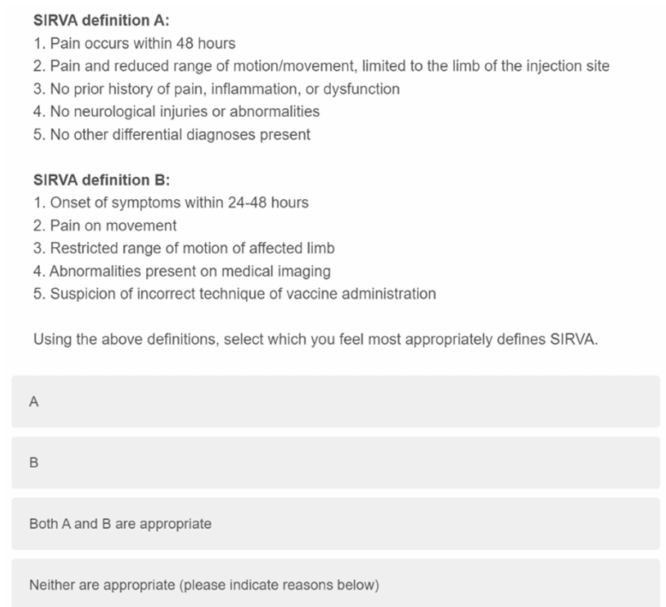
Figure 3. Qualtrics question examining SIRVA diagnostic criteria